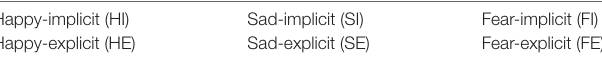
healthy sample. Twenty-three participants (19%) scored between 9 and 17 on the MADRS, meeting scale criterion for mild depression. Three participants scored above 20 on the MADRS, and could thus be considered moderately depressed.